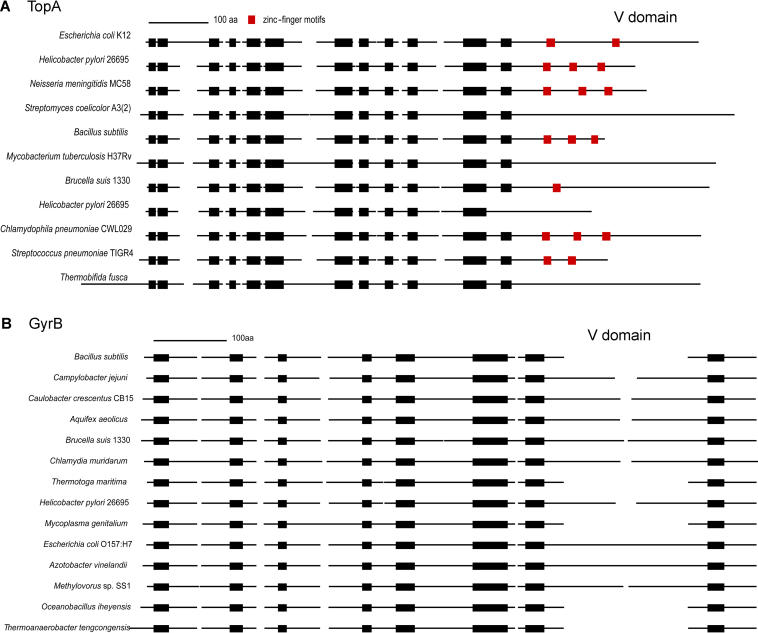
Schematic Alignment of TopA and GyrB(A) TopA. (B) GyrB. Each line represents a sequence. Black boxes indicate the conserved blocks from the BLOCKS database and are aligned correspondingly. Red boxes in (A) are the zinc-finger motifs reported by Pfam. Notice that the number of occurrences of this motif varies and that there are several sequences without this motif in the C-terminal. The lines between the boxes are the variable sequences that cannot be aligned. Variable domains are labeled in the figure.